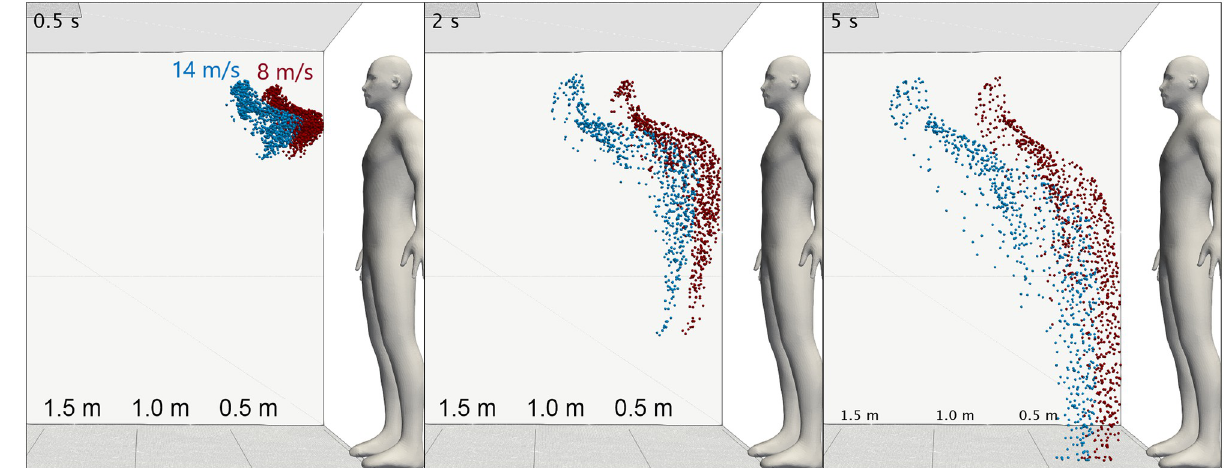
Fig 7. CFD simulations: Coughing. Comparison of droplet cloud shape and positions at t = 0.5, 2 and 5 s for a low velocity (red) and high velocity (blue) cough.